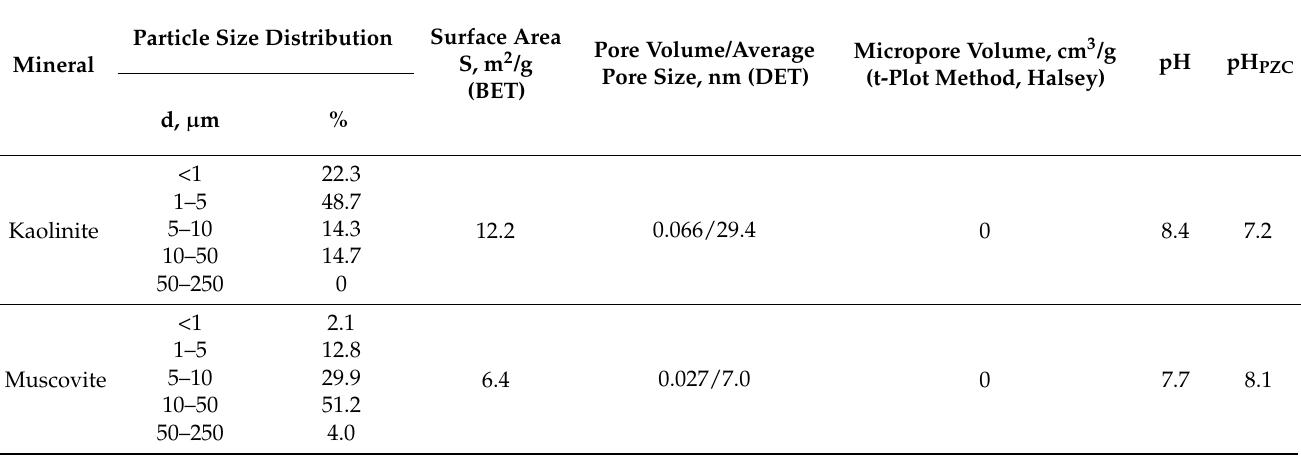
Table 1. Textural and surface properties of kaolinite and muscovite.